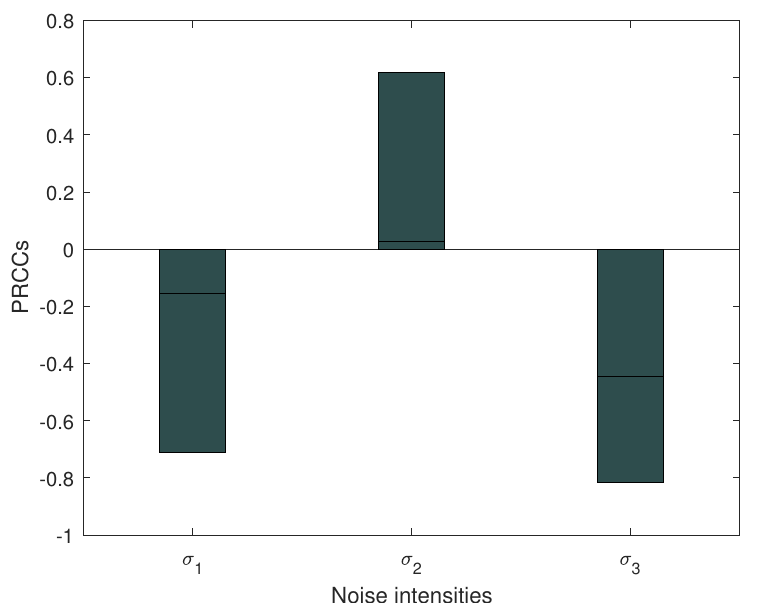
Figure 5. Partial rank correlation coefficients (PRCCs) for the average value of extinction time X over 1000 simulations for z ( t ) in model (2) with respect to σ 1 , σ 2 , and σ 3 . Under parameters b 2 = 0.73, σ i = 0.01 ( i = 1,2,3 ) , the other parameters from Table 1, s ( t ) and i ( t ) are persistent with probability one, while z ( t ) is extinct with probability one. The initial values of the solutions are ( 0.08,0.06,0.05 )